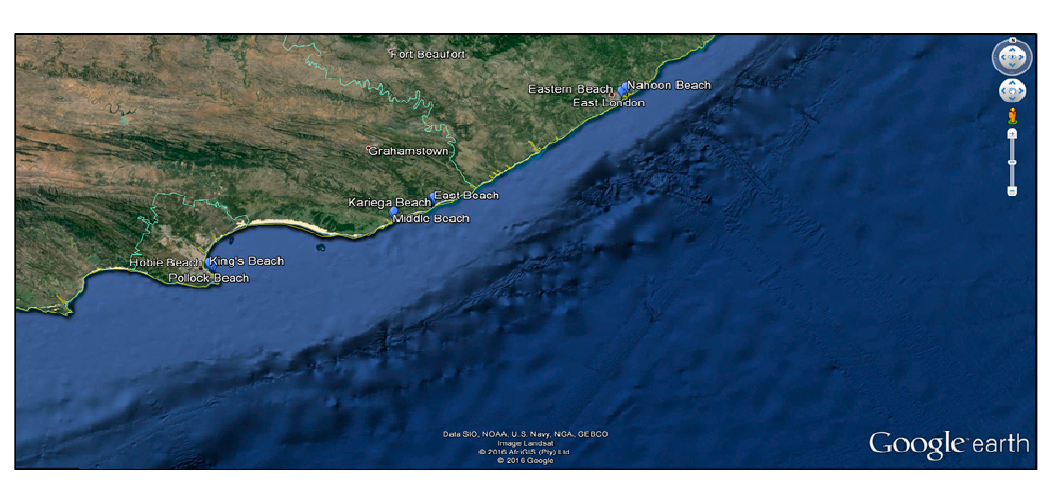
Table 1. The PCR products were separated by agarose gel electrophoresis in 1% agarose, stained with ethidium bromide. A 100 bp DNA ladder was included in each